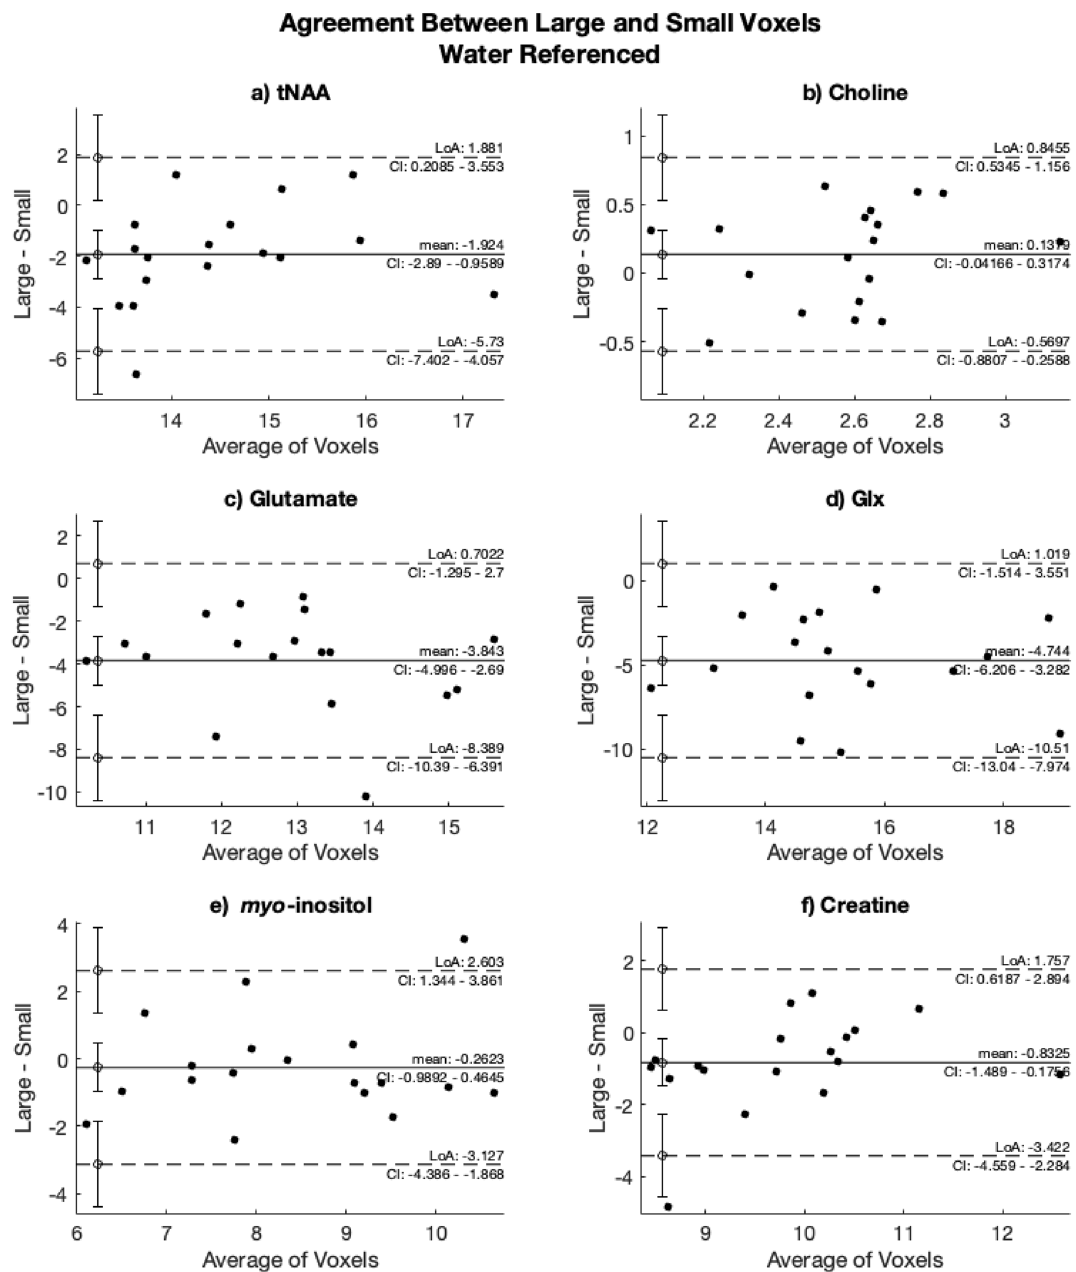
Figure 9. Bland–Altman plots illustrating agreement between the large voxel with full SNR and the small voxel, using the water-referenced data for ( a ) tNAA, ( b ) Choline, ( c ) Glutamate, ( d ) Glx, ( e ) myo-inositol and ( f ) Creatine. The y-axis shows the difference between the large and small voxels (large minus small) and the x-axis shows the average of the metabolite